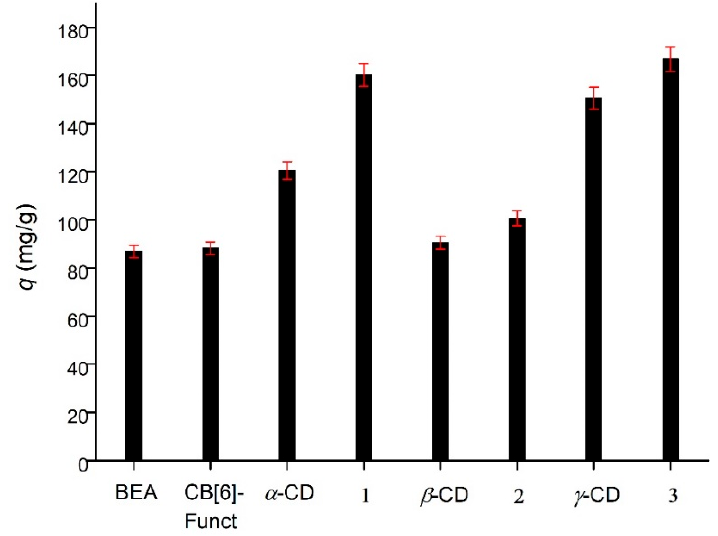
Figure 1. Quantification of CO 2 adsorption by the examined materials.